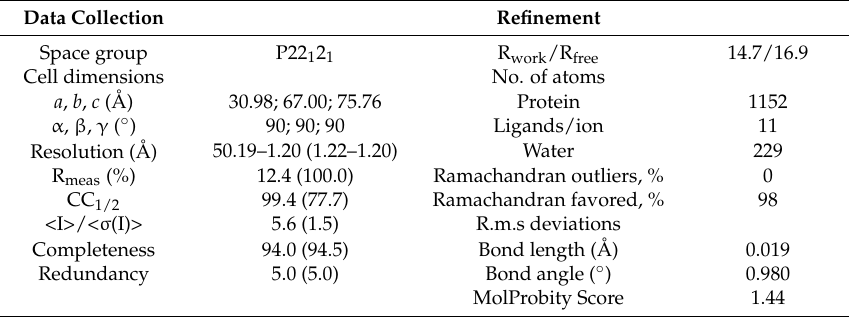
Table 2. Data collection and refinement statistics of